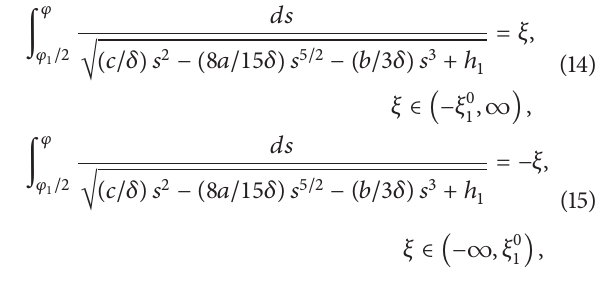
𝐴 𝑙 2 or 3 or 2 .